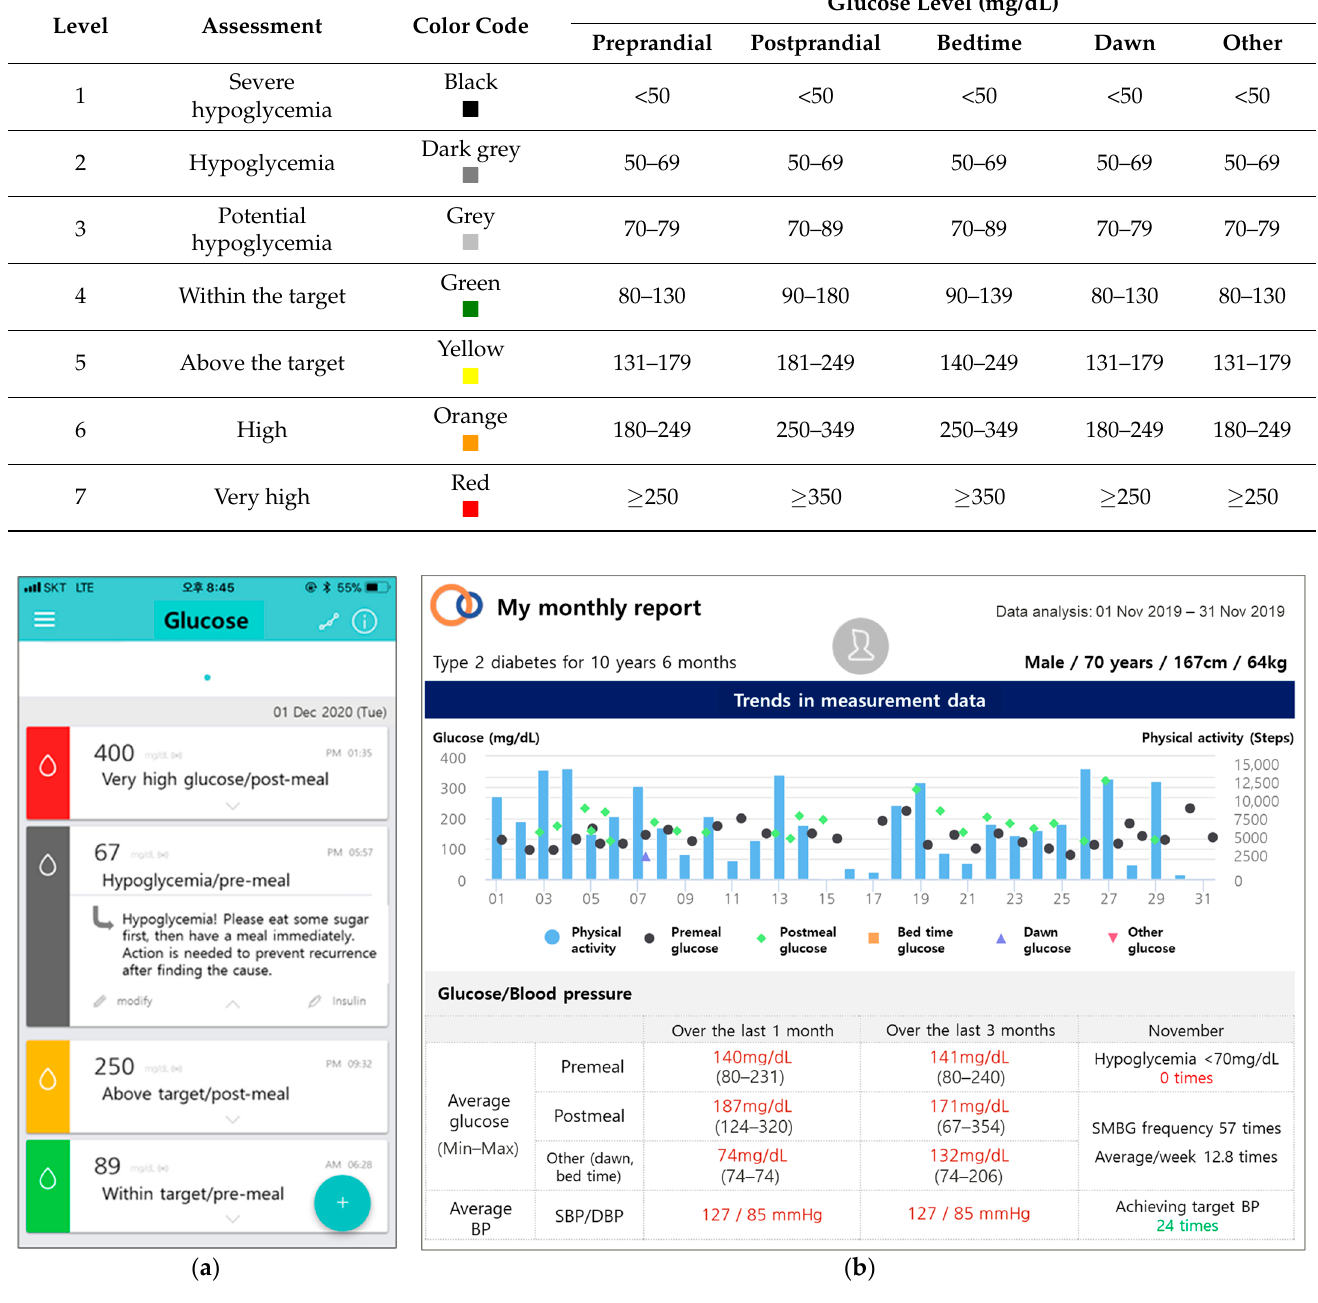
Figure 3. Examples of visual information of glycemic status ( a ) and a monthly report ( b ) on a web-based diabetes management system integrated with a mobile application.